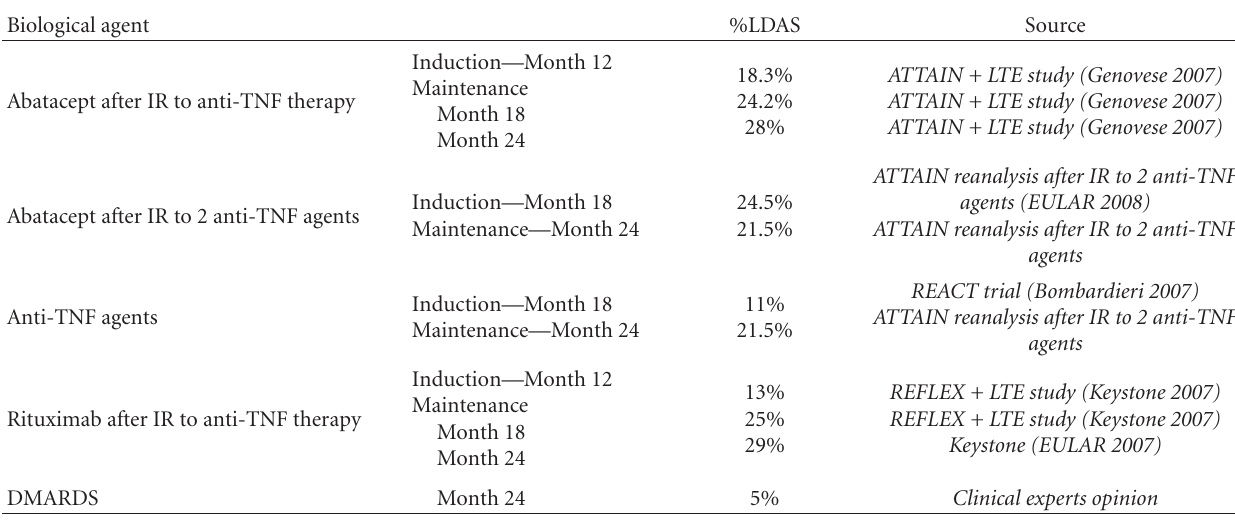
Table 3: Summary of e ff ectiveness probabilities (percentage of patients achieving